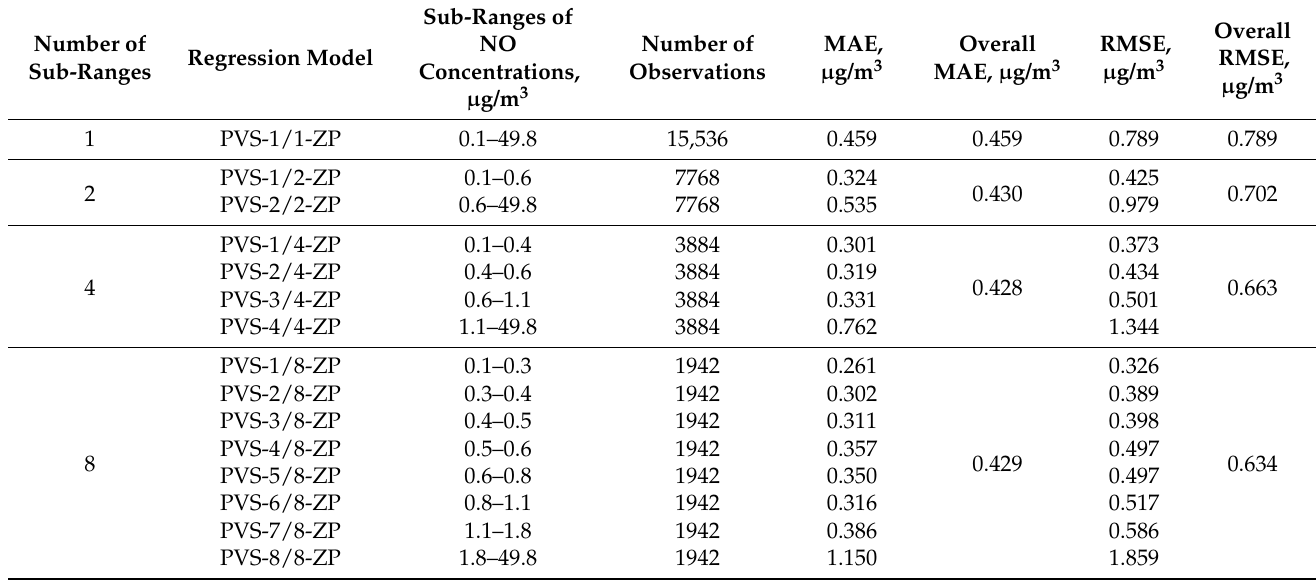
Table 8. Values of approximation errors of NO concentrations in PVS models, Złoty Potok